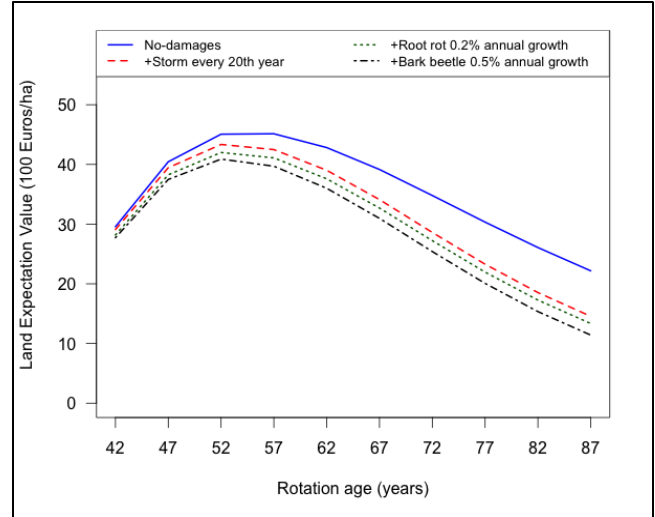
Figure 4. Land expectation values for Norway spruce stand (SI = G34*) in southern Sweden under “No-damages” scenario and adding the risk factors such as storm damage, root rot infection and bark beetle damage to the “No-damages” scenario in current climate. * The letter represents site index species, G = Norway spruce, and the number in the site index shows the height (m) the stand attains at an age of 100 years.